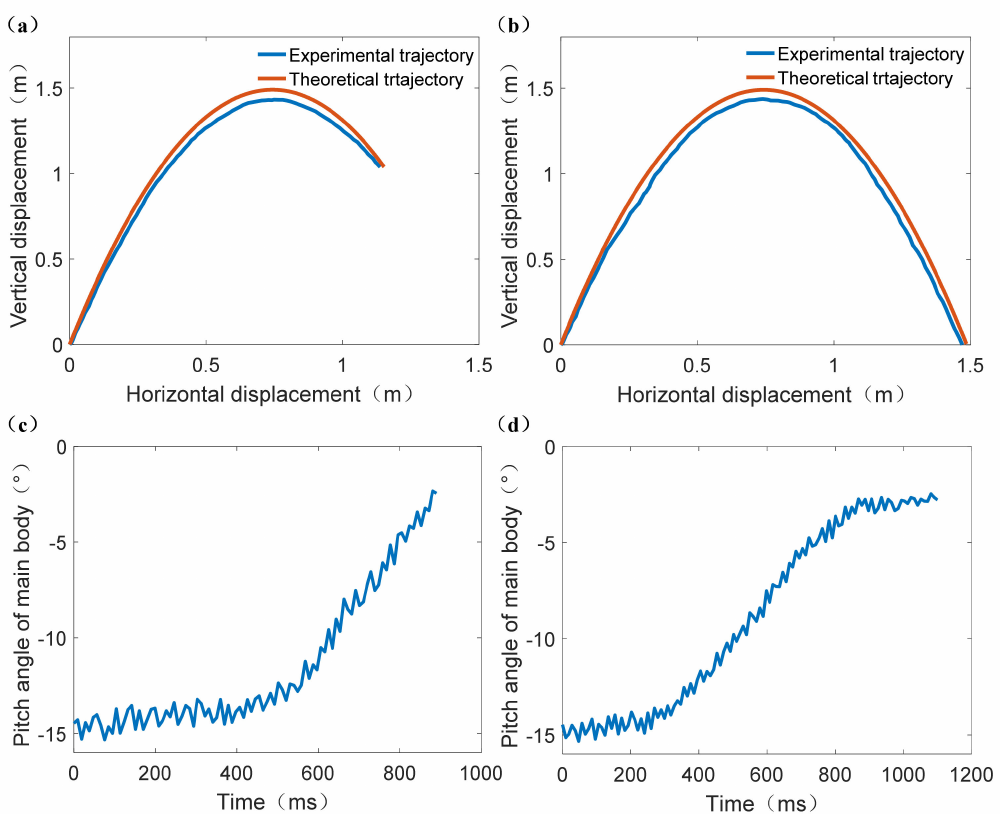
Figure 14. The jumping robot’s jumping trajectories and pitch angle curves of the obstacle-crossing experiment. ( a ) The comparison of jumping robot’s centroid trajectory of the experiment of jumping onto the platform. ( b ) The comparison of the jumping robot’s centroid trajectory of the experiment of jumping over the platform. ( c ) The pitch angle curve of the experiment of jumping onto platform. ( d ) The pitch angle curve of the experiment of jumping over platform. Both the desired pitch angle of main body in ( c , d ) are 0 ◦